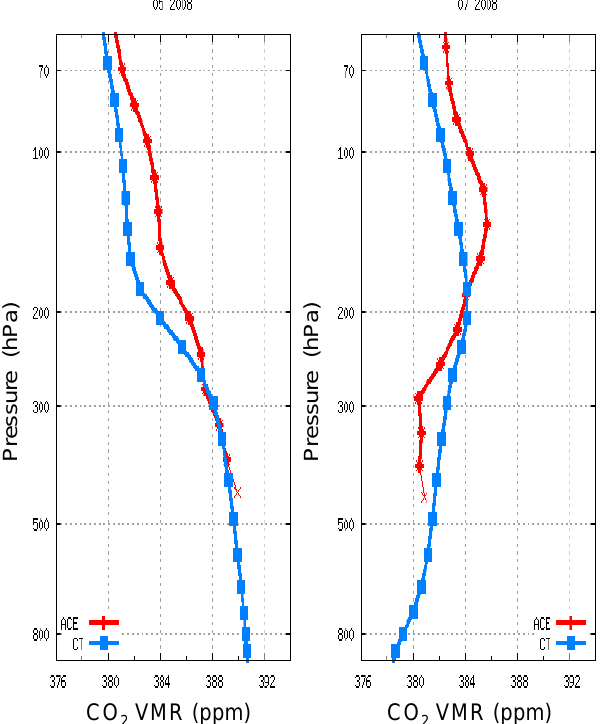
Fig. 12. CT (blue) and ACE (red) CO 2 profiles for the 50 ◦ N–60 ◦ N latitude band in 2008. ACE profiles in May (left) and July (right) are compared to CT profiles of one month before (top), and of one month after (bottom). ACE thin red line indicates that less than 10 occultations were